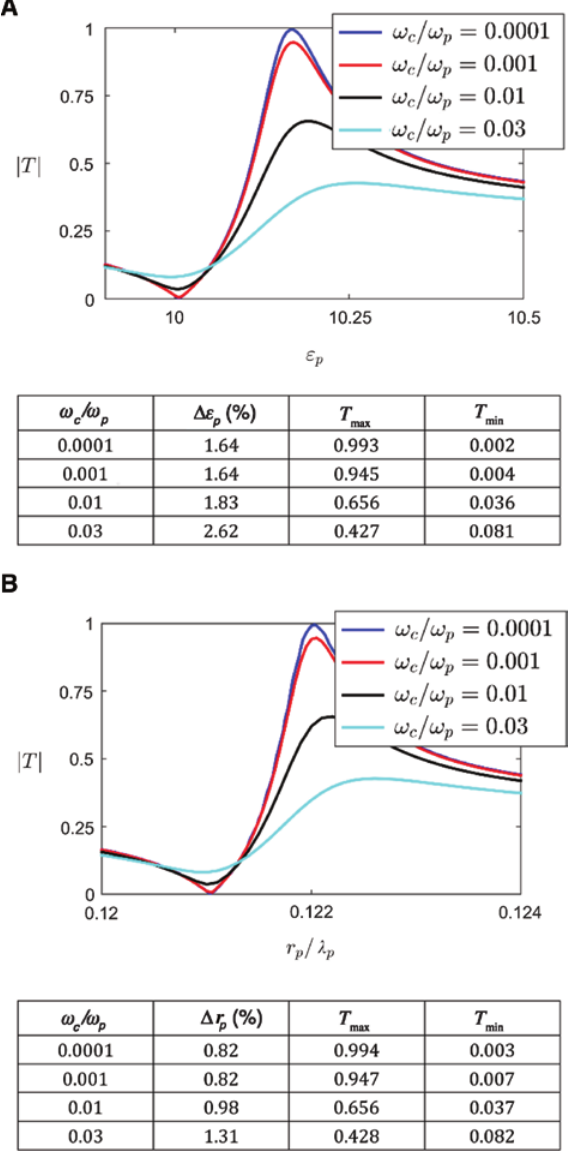
Figure 4: Switching ENZ metasurfaces photonically doped with a single